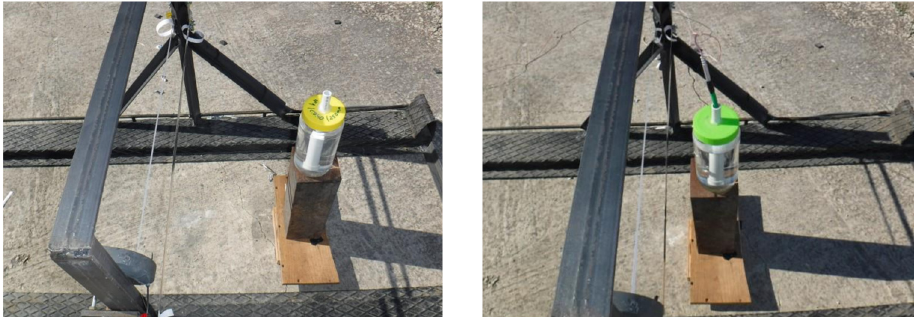
Figure 6. Counter-IED loads (with and without detonator), placed next to speed measurement frame.